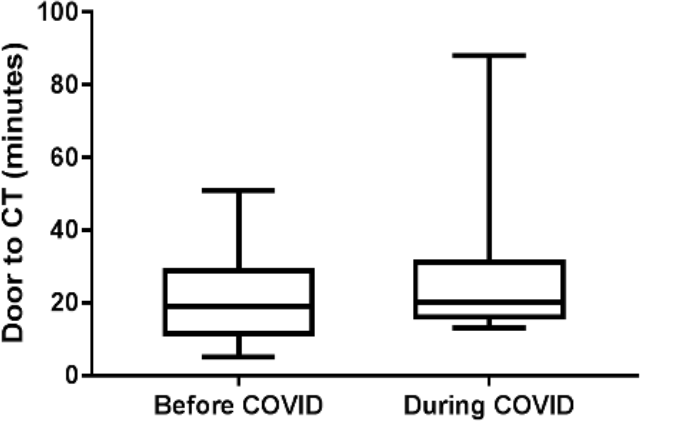
Figure 2. A comparison of door-to-CT times between the during COVID-19 and pre-COVID-19 period groups. Compared with the pre-COVID-19 group, the during COVID-19 group showed no major difference in median door to CTA time (19 min vs. 20 min, respectively; p = 0.398). Additionally, there was no major difference in median door-to-puncture time (Figure 3A) (118.0 min vs. 109.0 min, respectively; p = 0.281) and no different rate of reaching an intent DTP time of ≤ 90 min (15.2% vs. 17.9%, respectively; p = 1.000) (Figure 3B) and 120 min (54.5% vs. 67.9% respectively; p = 0.452) (Figure 3C). The prognosis of the during-COVID-19 group showed no difference in the rate of TICI score = 2b \ 2c \ 3 (30% vs. 21%) and no difference in the rate of mRS score after MT three months ≤ 2 score (pre-COVID-19 group/during COVID-19 group: 21.4%: 27.3%) (Figure 4).